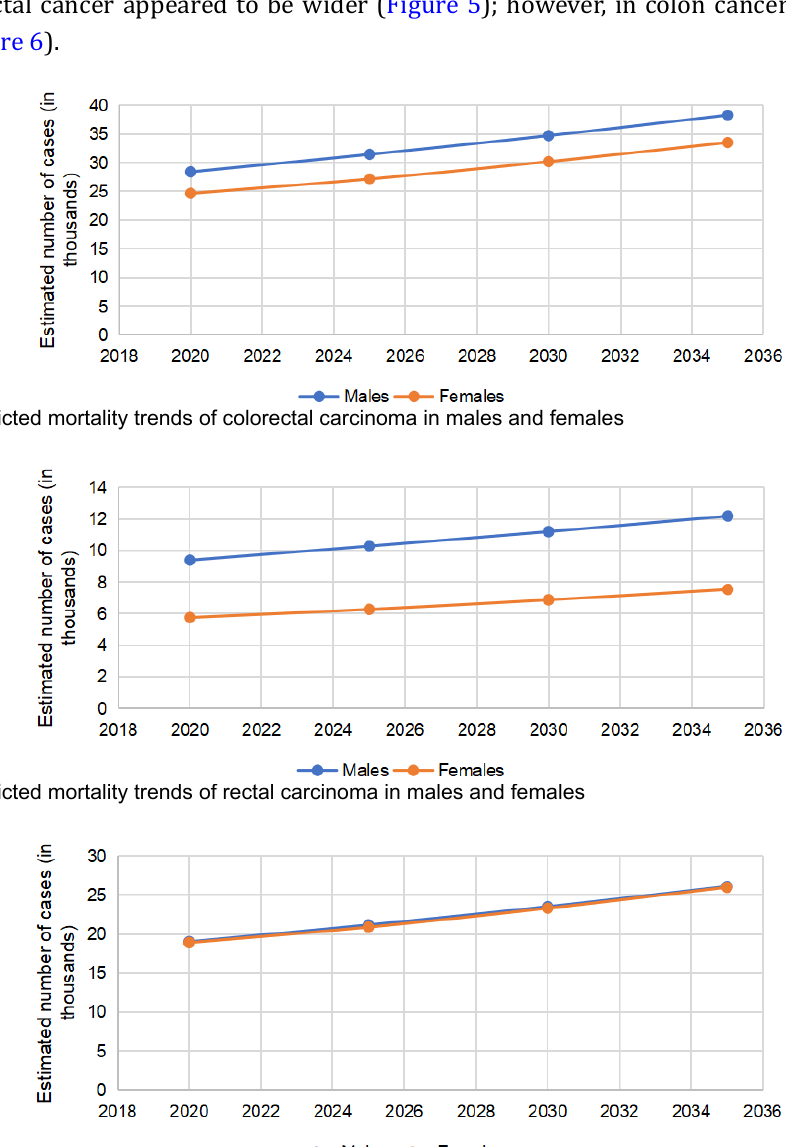
Figure 6. Predicted mortality trends of colon carcinoma in males and